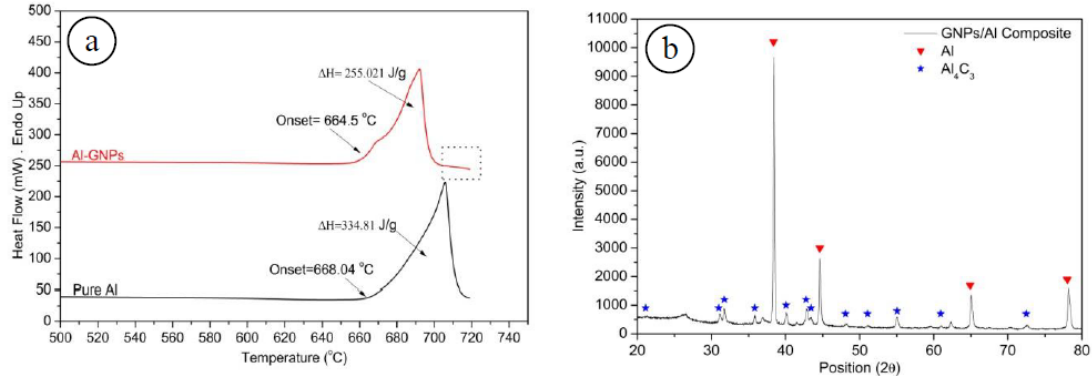
Figure 9. ( a ) Differential scanning calorimetry curves of pure Al and Al-2.0 wt. % GNPs; ( b ) X-ray diffraction pattern of Al-2.0 wt. % GNPs after the thermal analysis, reproduced from [97], with permission from from Springer Nature,